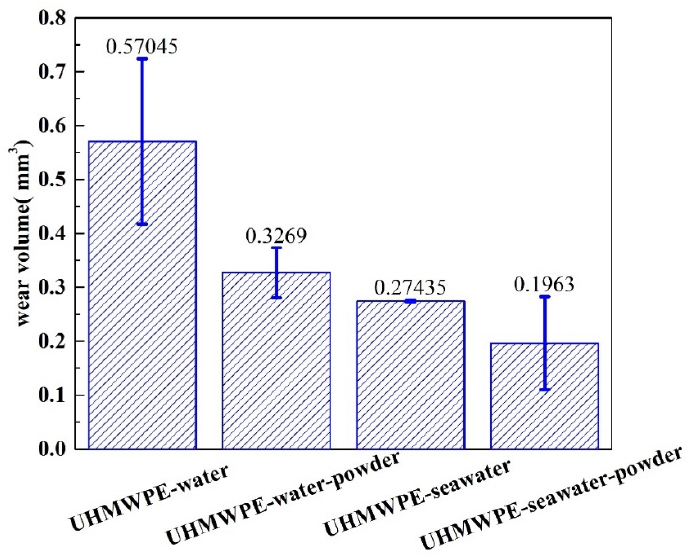
Figure 2. Wear amount of UHMWPE pins tested using pin–disc friction and wear tester. The error bar in the Figure represents the standard deviation.